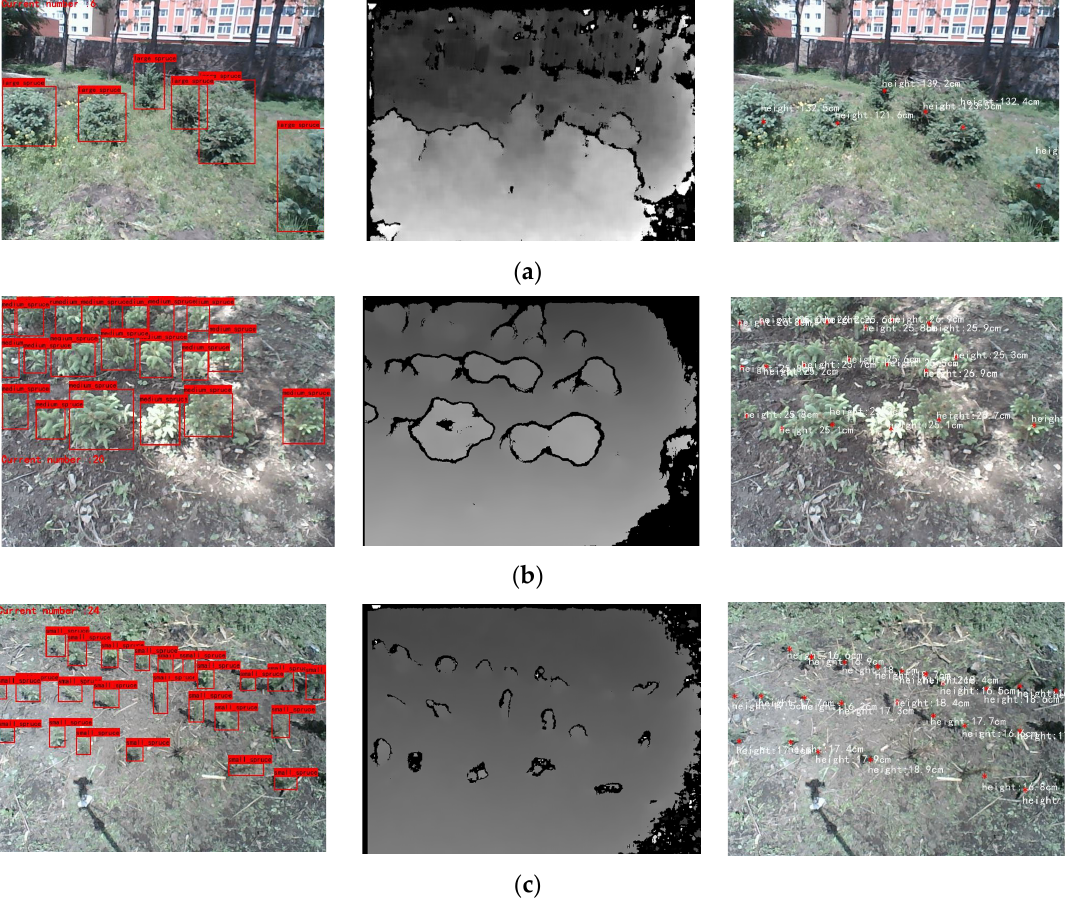
Figure 7. Spruce saplings’ detection images: ( a ) large, ( b ) medium and ( c ) small